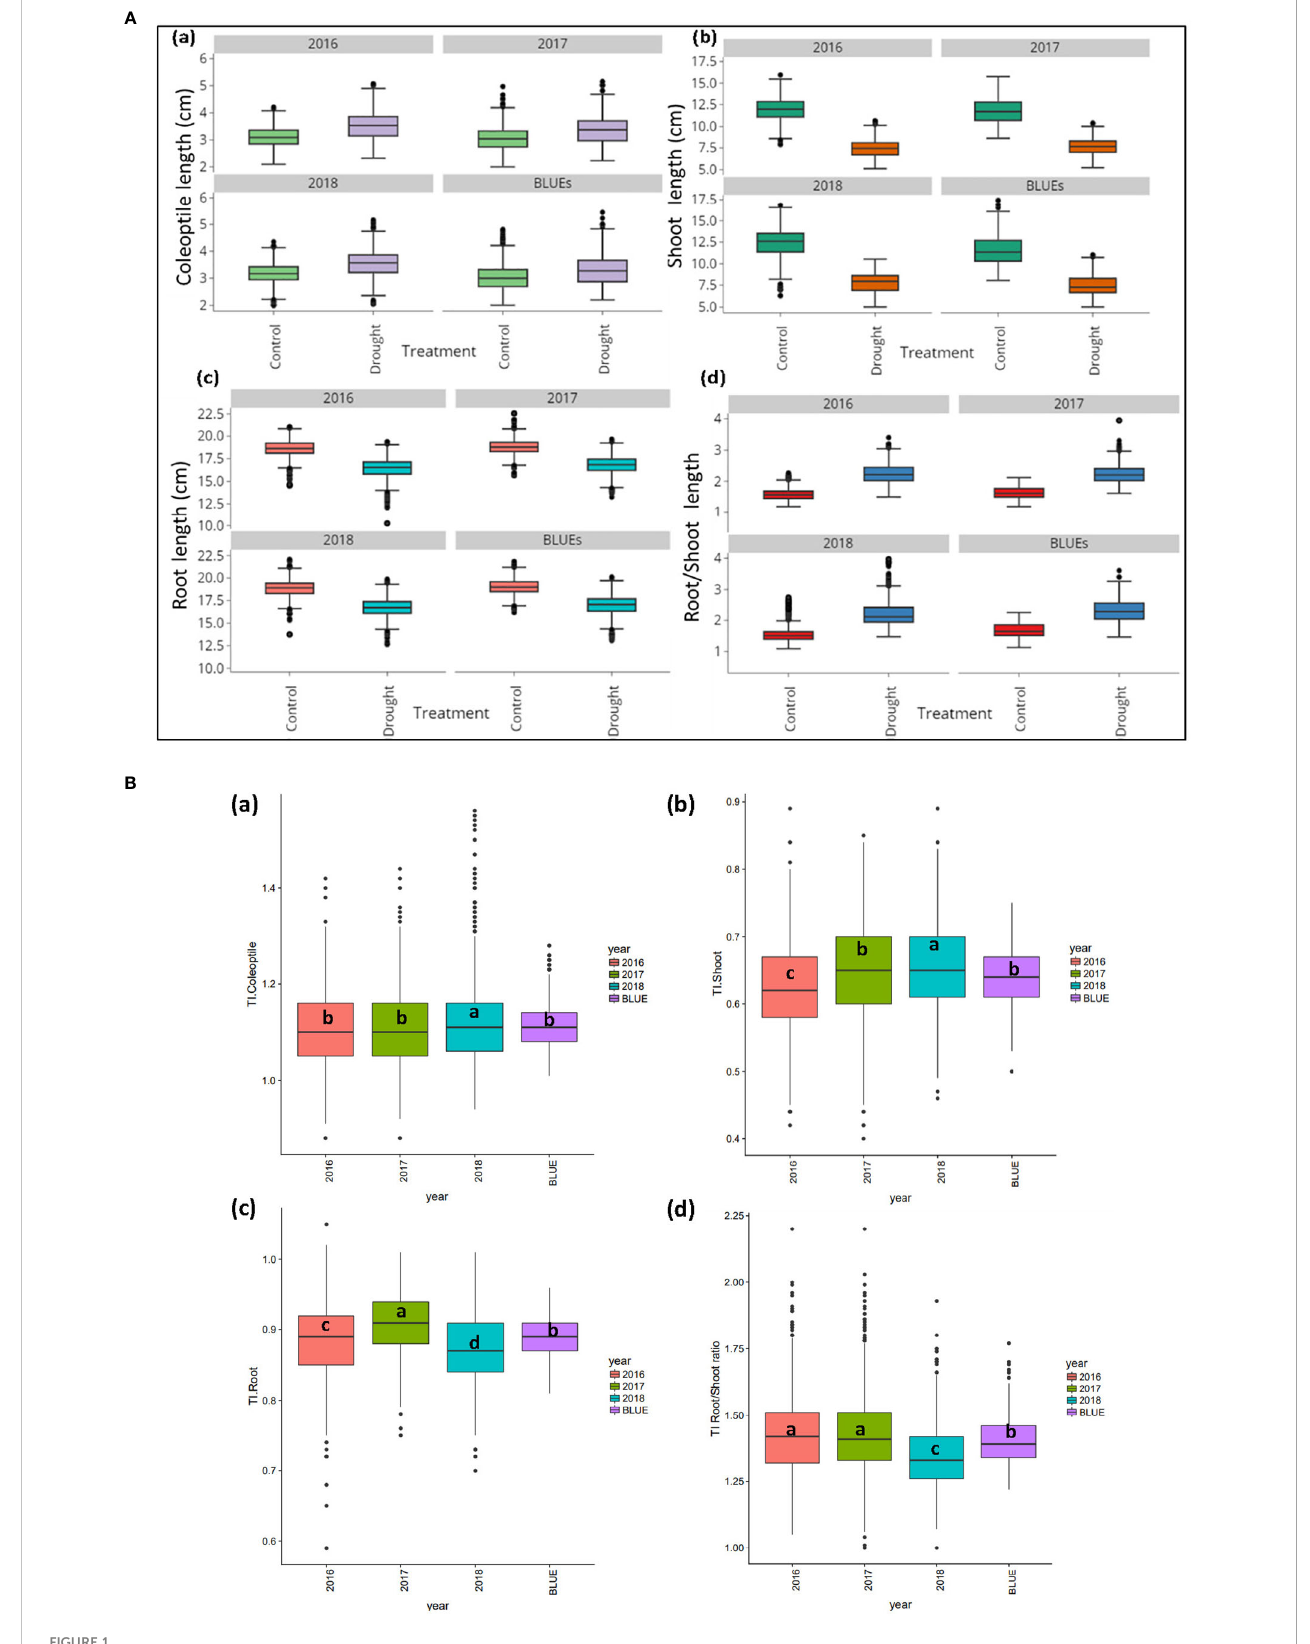
FIGURE 1 (A) Boxplot for real values for three years and BLUEs values for a) Coleoptile length (cm), b) Shoot length (cm) (c) Root length (cm), and d) Root/Shoot ratio in 261 winter wheat genotypes under control and drought stress. (B) . Boxplot for three years and BLUEs values for a) Coleoptile length tolerance index, b) Shoot length tolerance index c) Root length tolerance index and d) Root/Shoot ratio tolerance index in 261 winter wheat